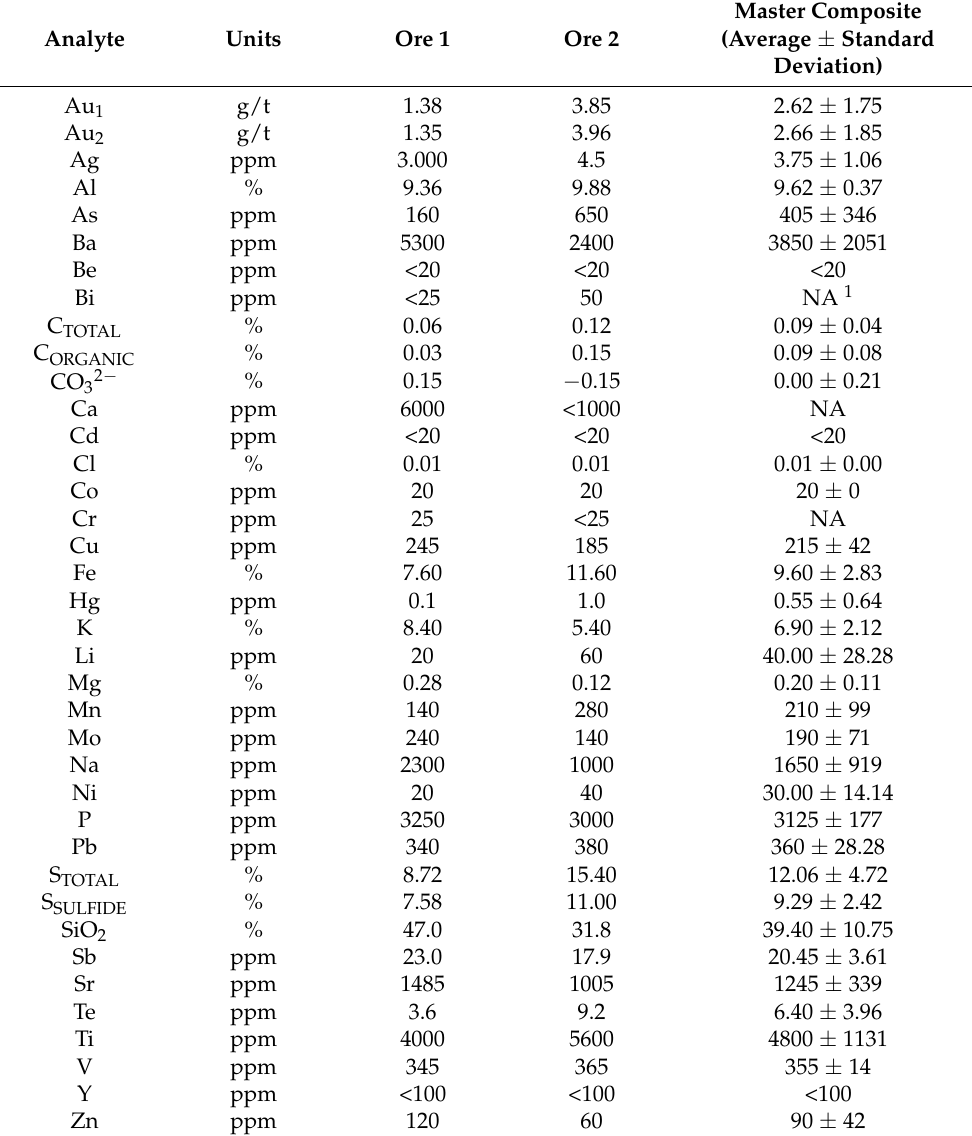
Table 3. Elemental composition of the pyrite ores and average values representing the master composite used for the pyrite oxidation